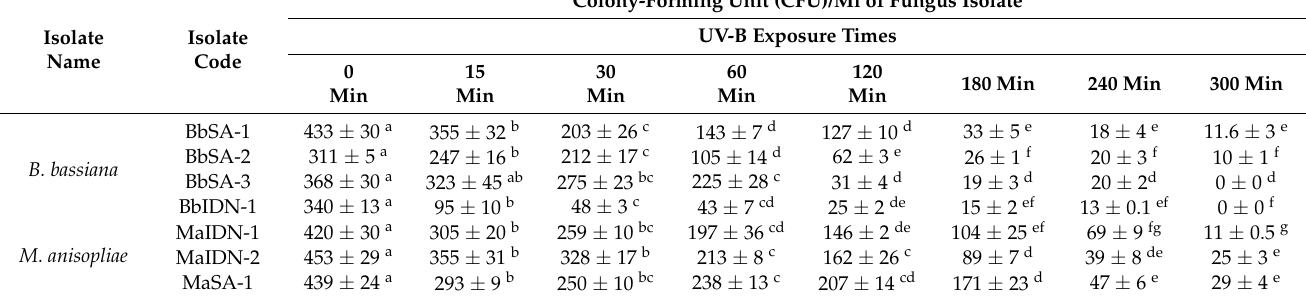
Table 2. The effect of different UV-B irradiation exposure times on fungi isolate persistency based on the number of colony-forming units (CFU).